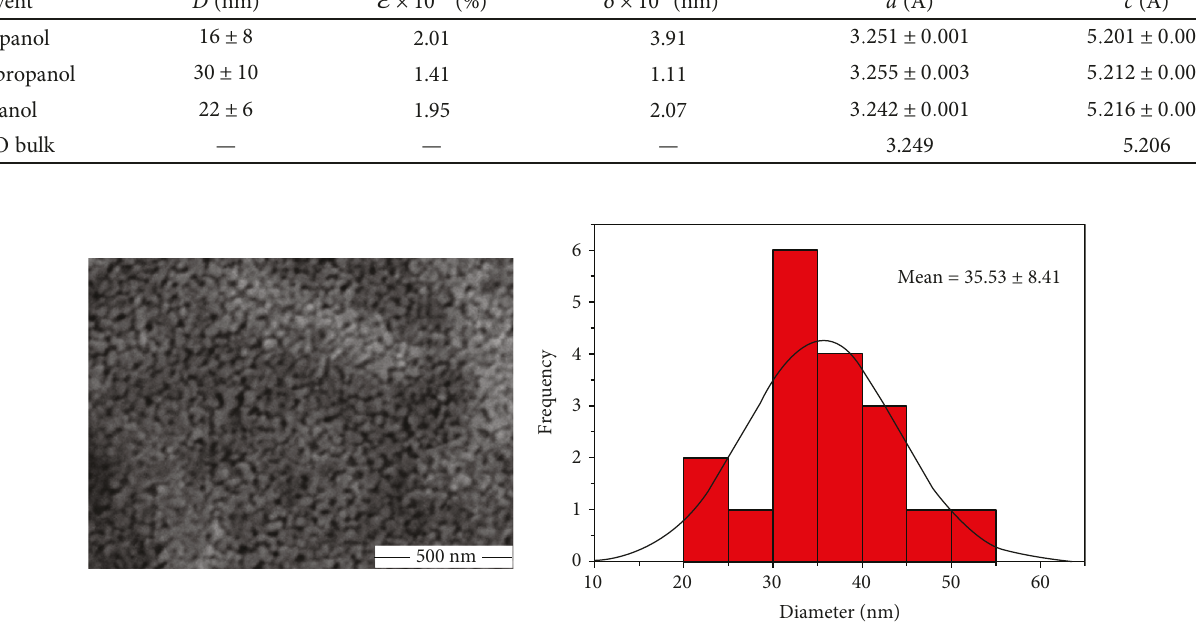
Figure 3: SEM image and particle size distribution of the ZnO thin fi lms obtained using isopropanol as solvent.